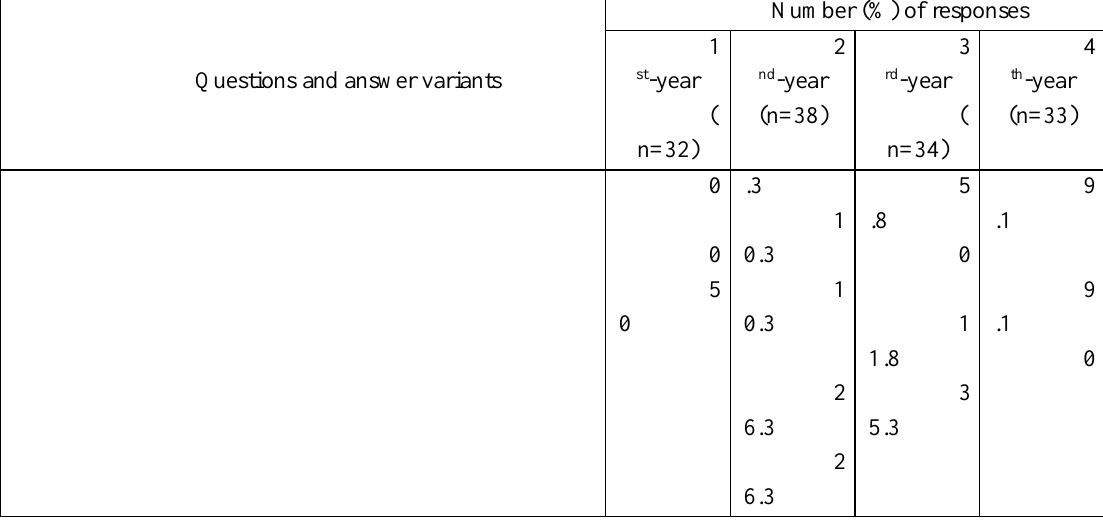
Table 2. Some results of the questionnaire survey of students of the faculty of physical culture and sports on the organization of research work in Vyatka State